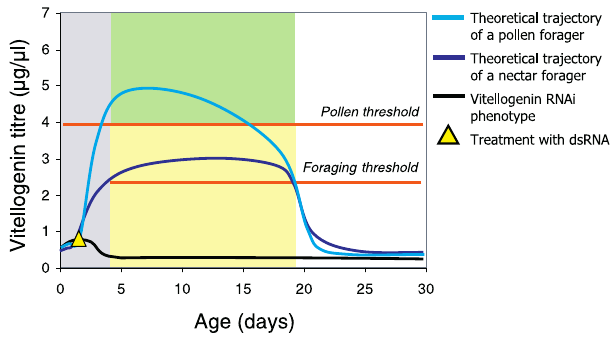
Figure 5. Vitellogenin Has a Dual Role in Regulation of Social Behavior After the maturation phase, when bees are unable to forage (grey) [37], vitellogenin suppresses the transition from nest tasks to foraging activity when its titer remains above the foraging threshold level [3,7]. Below this threshold, the probability of initiating foraging is increased [5]. Pre- foraging vitellogenin titers above the pollen threshold prime workers for pollen foraging (green), while workers with lower pre-foraging titers (yellow) are primed for nectar foraging [9]. vitellogenin RNAi causes workers to mature with vitellogenin titers that are below both